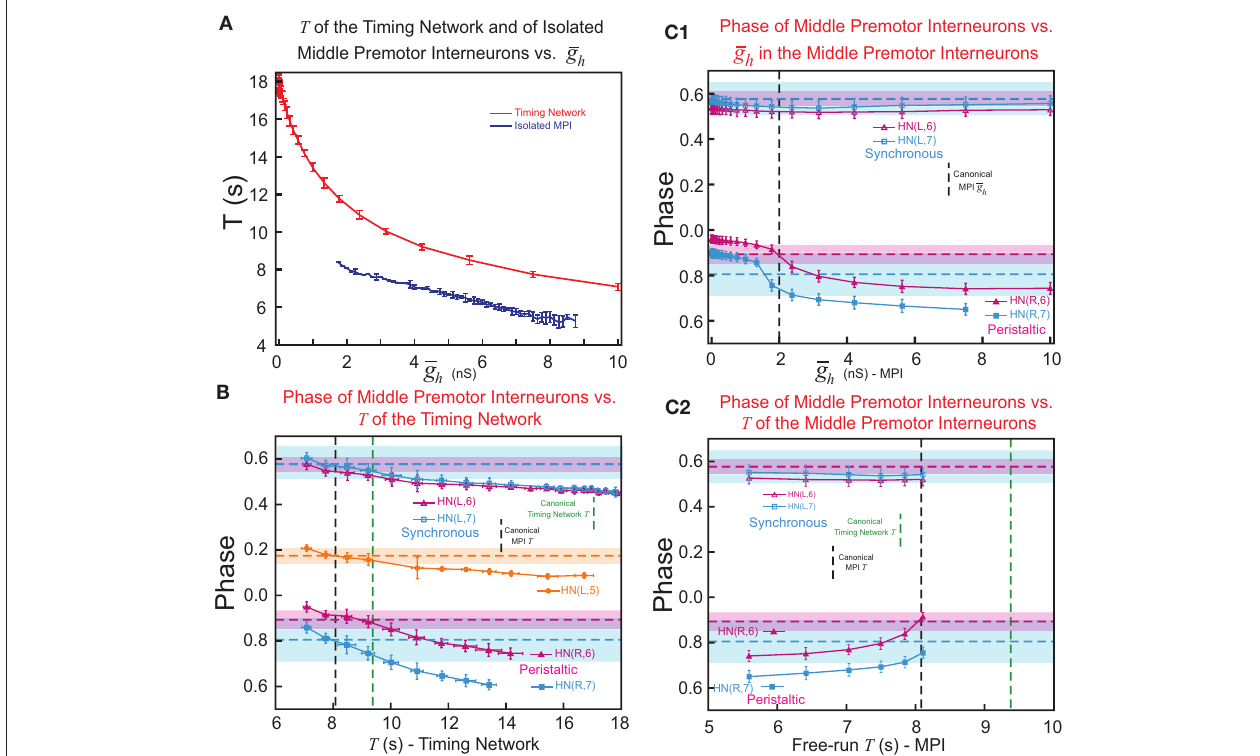
when successful one-for-one entrainment of the switch or premotor interneurons by the timing network could no longer be maintained. (C1) Varying g h in the HN(6) and HN(7) middle premotor interneurons caused a monotonic change in their phasing on both the synchronous (L) and peristaltic (R) side that saturated at both high and low values of g h . (C2) Using data from (A) giving the dependence of the intrinsic period of middle premotor interneurons on g h , the data from (C1) was re-plotted to show the effect of intrinsic period of the premotor interneurons on their phasing. In (B,C1,2) , data for each middle premotor interneuron, synchronous and peristaltic, is plotted separately using the neuronal symbols and color code. Horizontal dashed lines in a model neuron’s color code indicates the average phase observed in the living system and shading in a model neuron’s color code indicates the average phase ± 1.5 × SD observed in the living system. Vertical dashed lines indicate canonical cycle period values for the timing network (green) or the middle premotor interneurons (black,